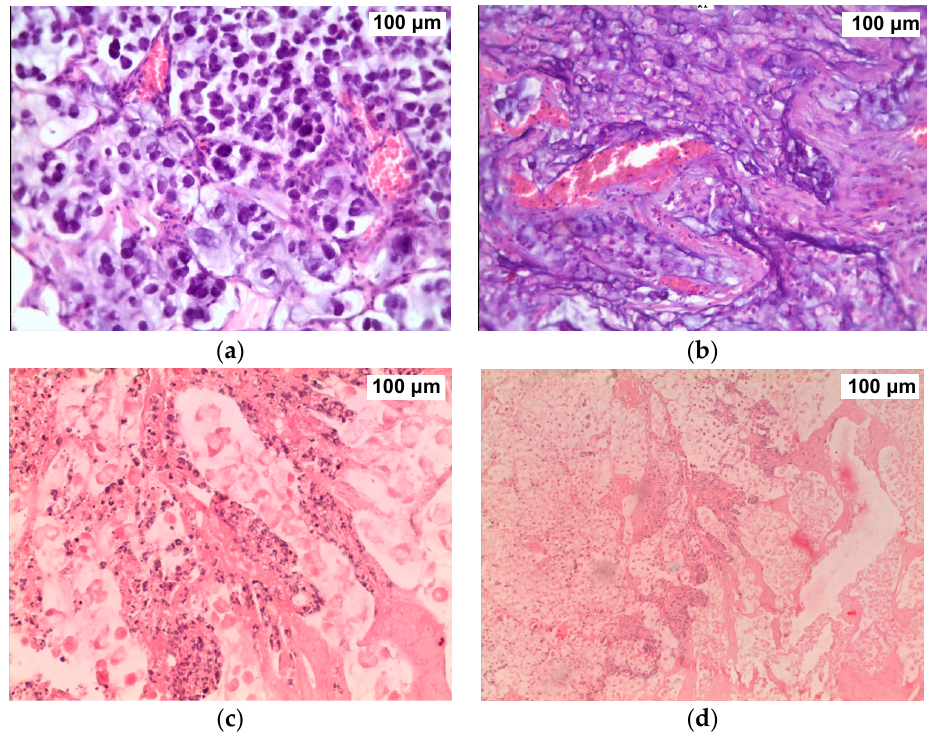
Figure 10. Liver tumor slices after different treatments: Comparison group with 808 nm laser irradiation only ( a ); PDT-group ( b ); PTT group ( c ); PDT + PTT group ( d ). H & E staining, ×246.4. Reproduced from [38] with permission from the Springer and Wiley.